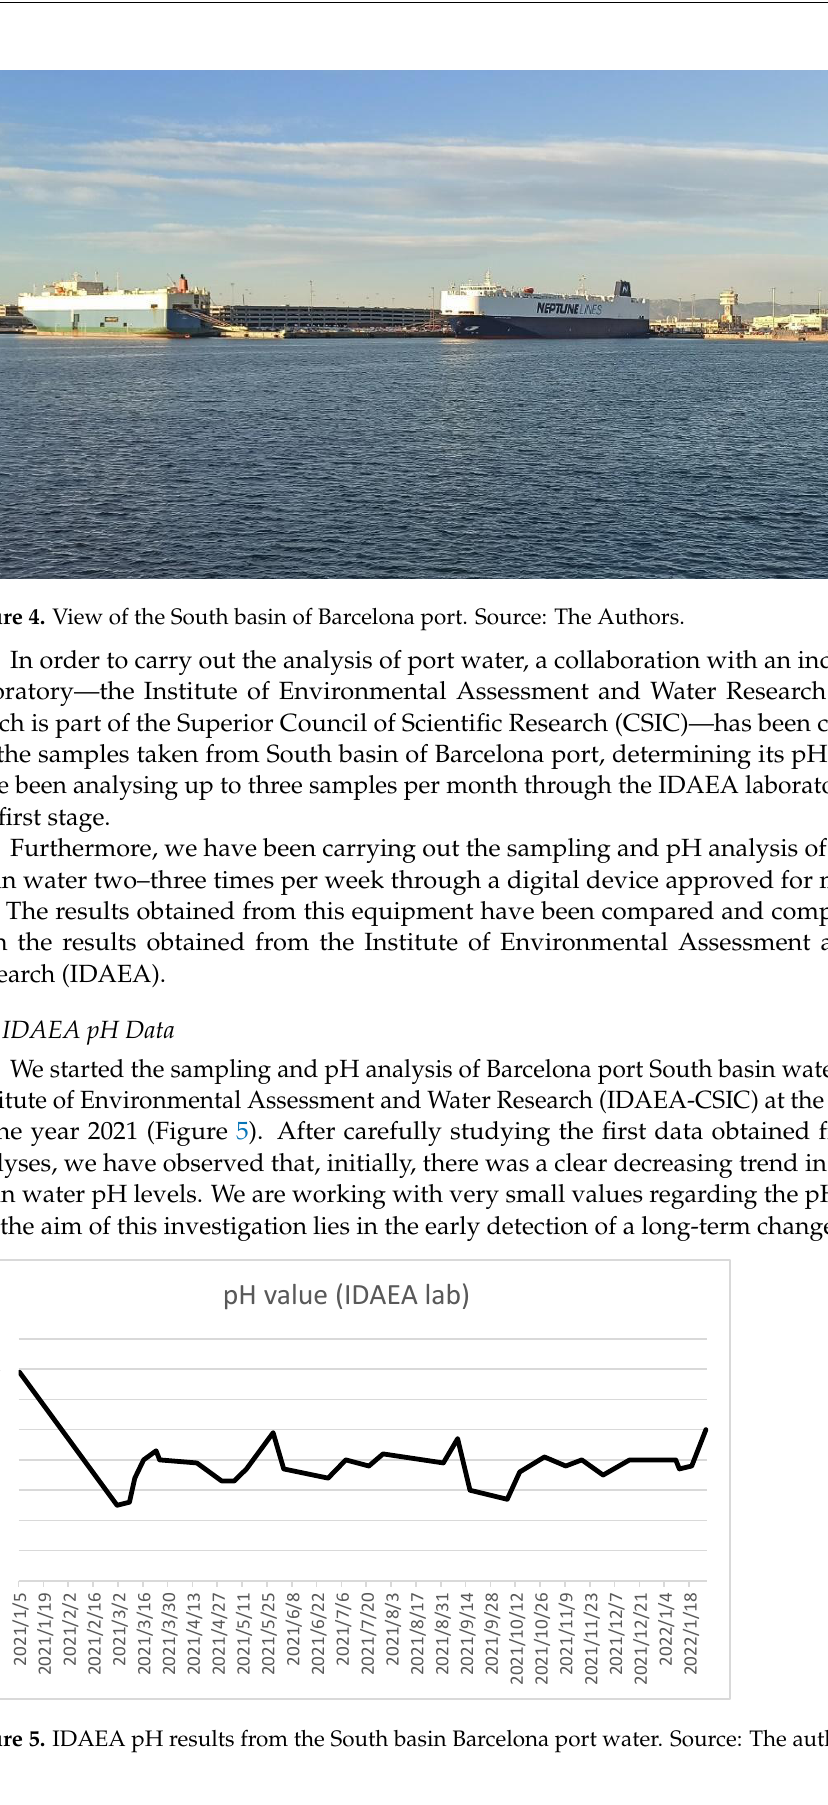
Figure 3. View of the South basin of Barcelona port. Source: elmercantil.com, (accessed on 14 March 2022).